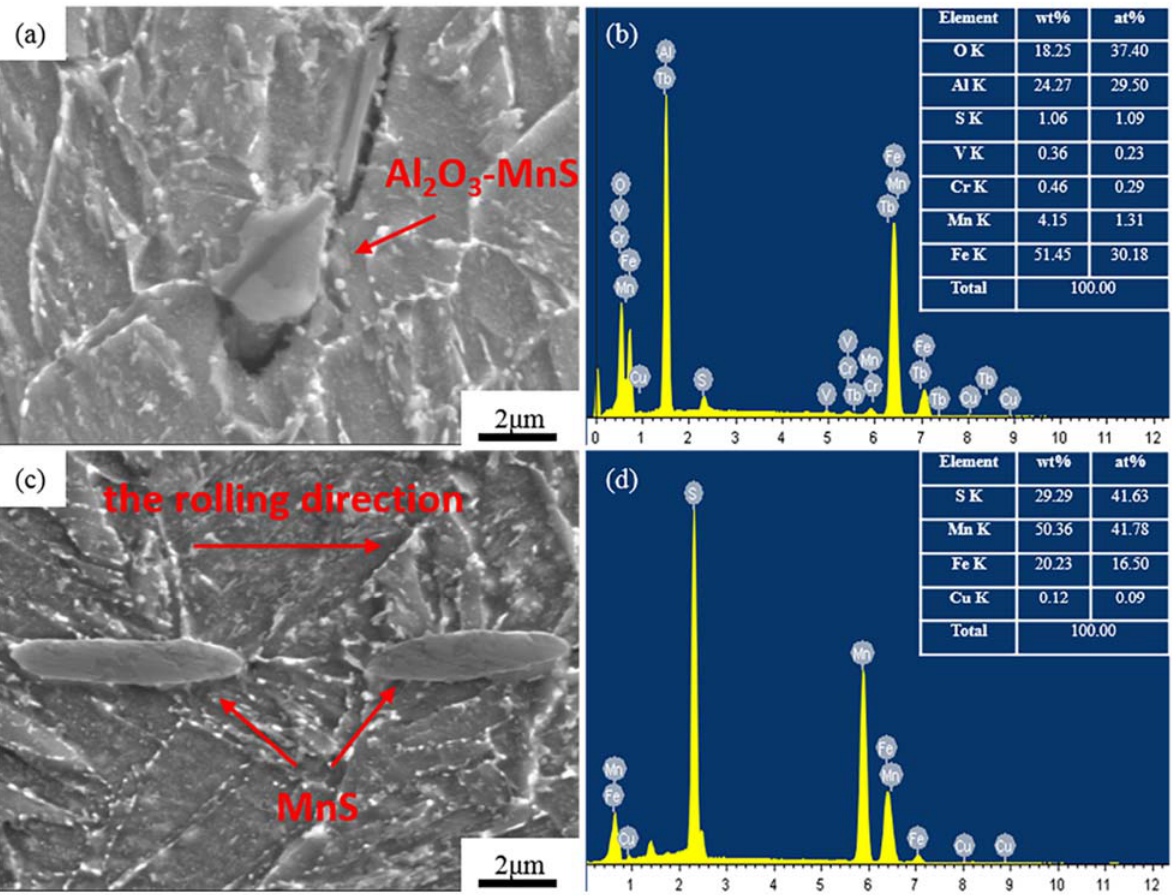
Figure 6. Typical inclusions in Al ‐ Steel. ( a ) The image of Al 2 O 3 ‐ MnS; ( b ) EDS of Al 2 O 3 ‐ MnS; ( c ) the image of MnS; ( d ) EDS of MnS.